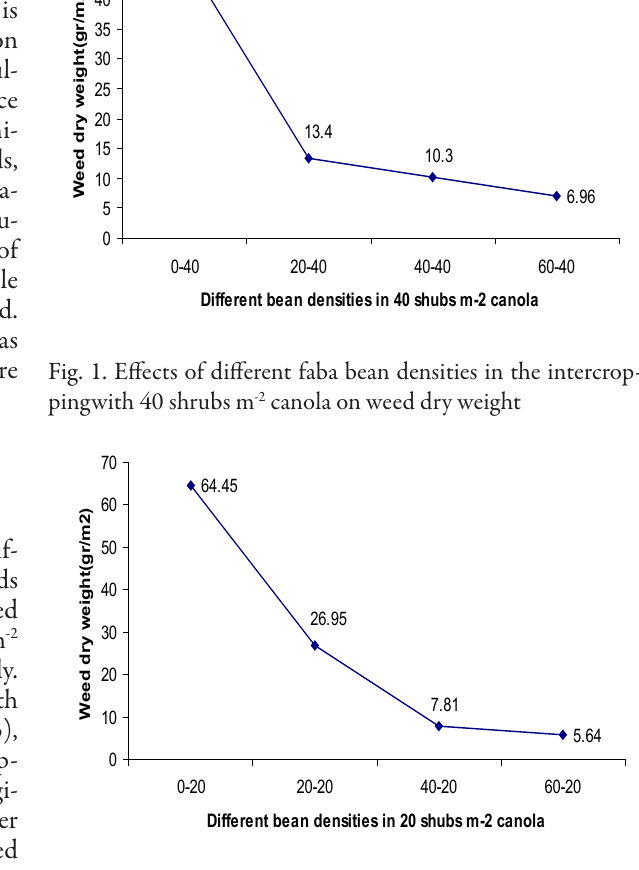
Fig. 2. Effects of different faba bean densities in the